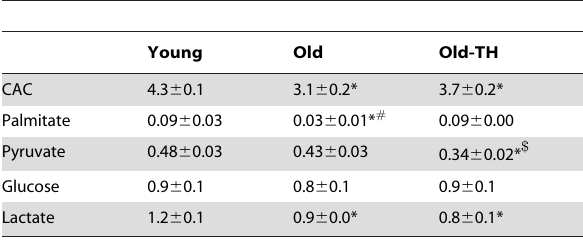
Table 4. Flux rates for total citric acid cycle (CAC) and individual substrates at high afterload.